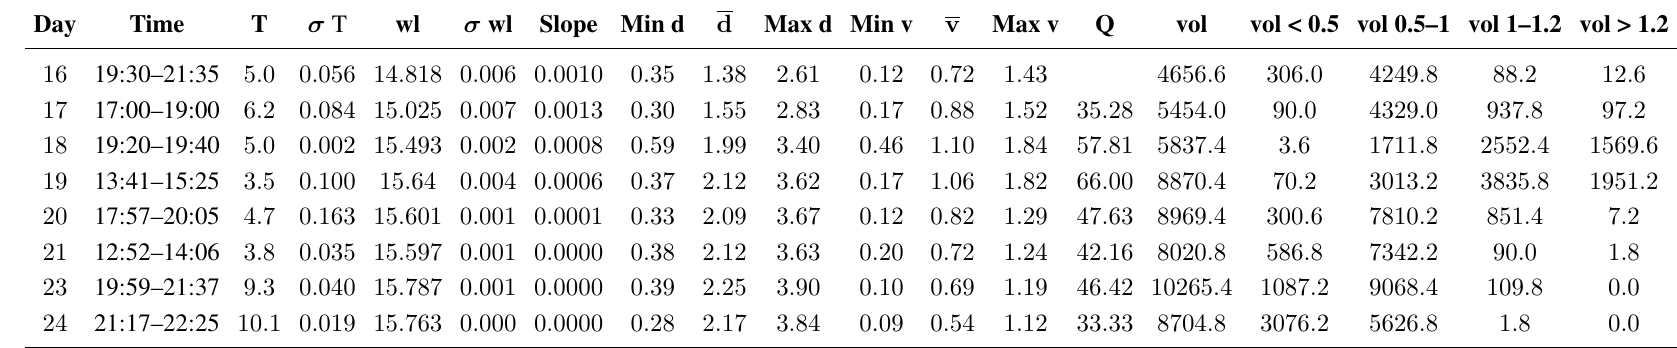
Table 2. Results of the 3D-interpolated point clouds for Venesärkkä for each day: time of measurement, temperature ( ◦ C) mean T and standard deviation σ T during measurement period, water level elevation mean wl (metres above sea level) and standard deviation σ wl